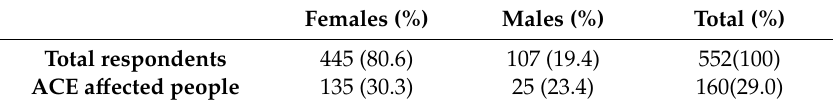
Table 2. Characteristics of the a ff ected sample. ACE: adverse cosmetic